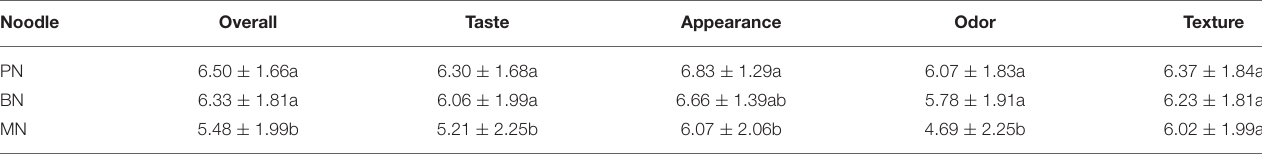
TABLE 3 | Mean value of attribute scores for noodle samples in 1 Aug and 14 Nov 2017.